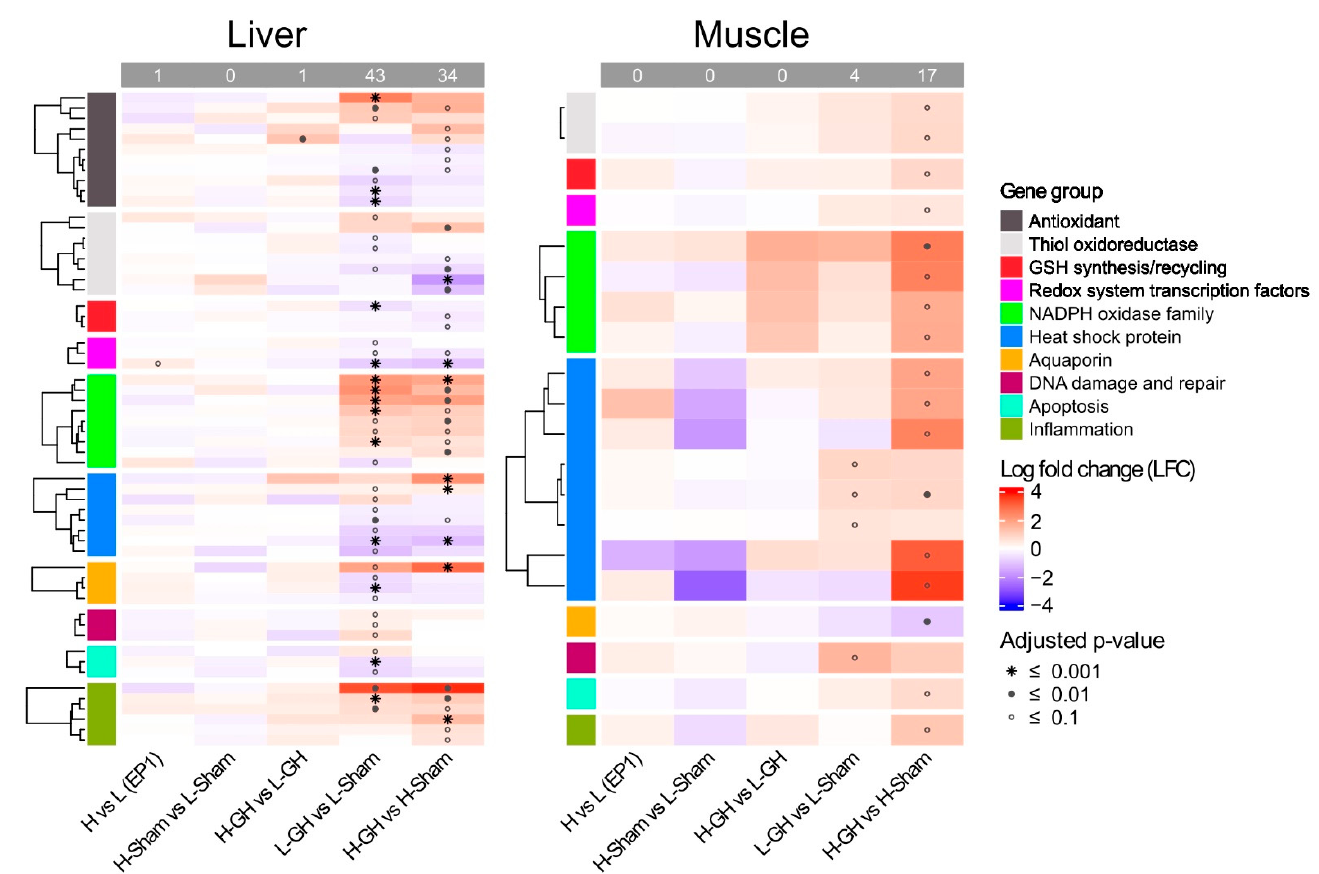
Figure 8. Expression of genes involved in redox system affected by dietary vitamins and GH implantation. Heat map of the expression of genes associated with the redox system over EP1 and EP2. Normalization genes was performed using size factors calculated by DESeq2, followed by log2 fold‐change (LFC) and adjusted p ‐ value estimates between sample group; red and blue indicate upregulated and downregulated expression, respectively, while the symbol *, •, and ⸰ indicate p ‐ values lower than 0.001, 0.01, and 0.1, respectively. Table 3. A summary of the changes in differentially expressed genes (DEGs) involved in redox sys ‐ tem regulation in response to GH and dietary vitamin C and E in liver and muscle of Atlantic salmon.